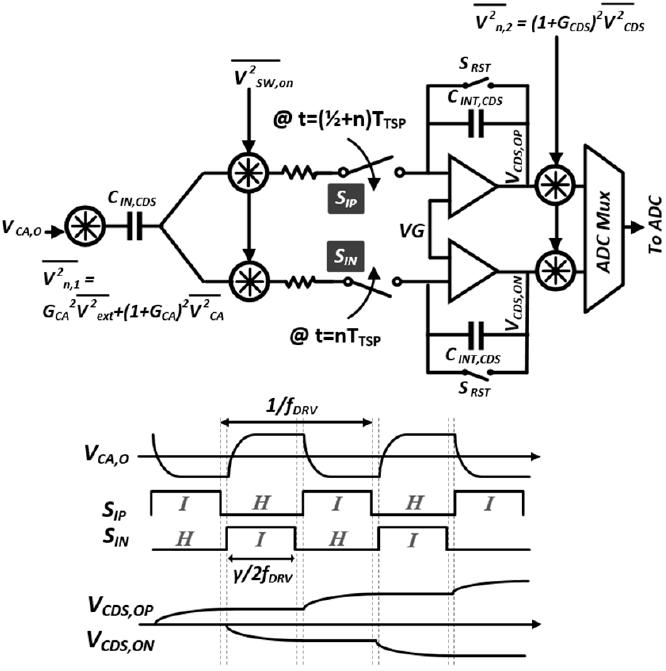
Figure 10. Schematic and timing diagram of the CDS with equivalent noise model.